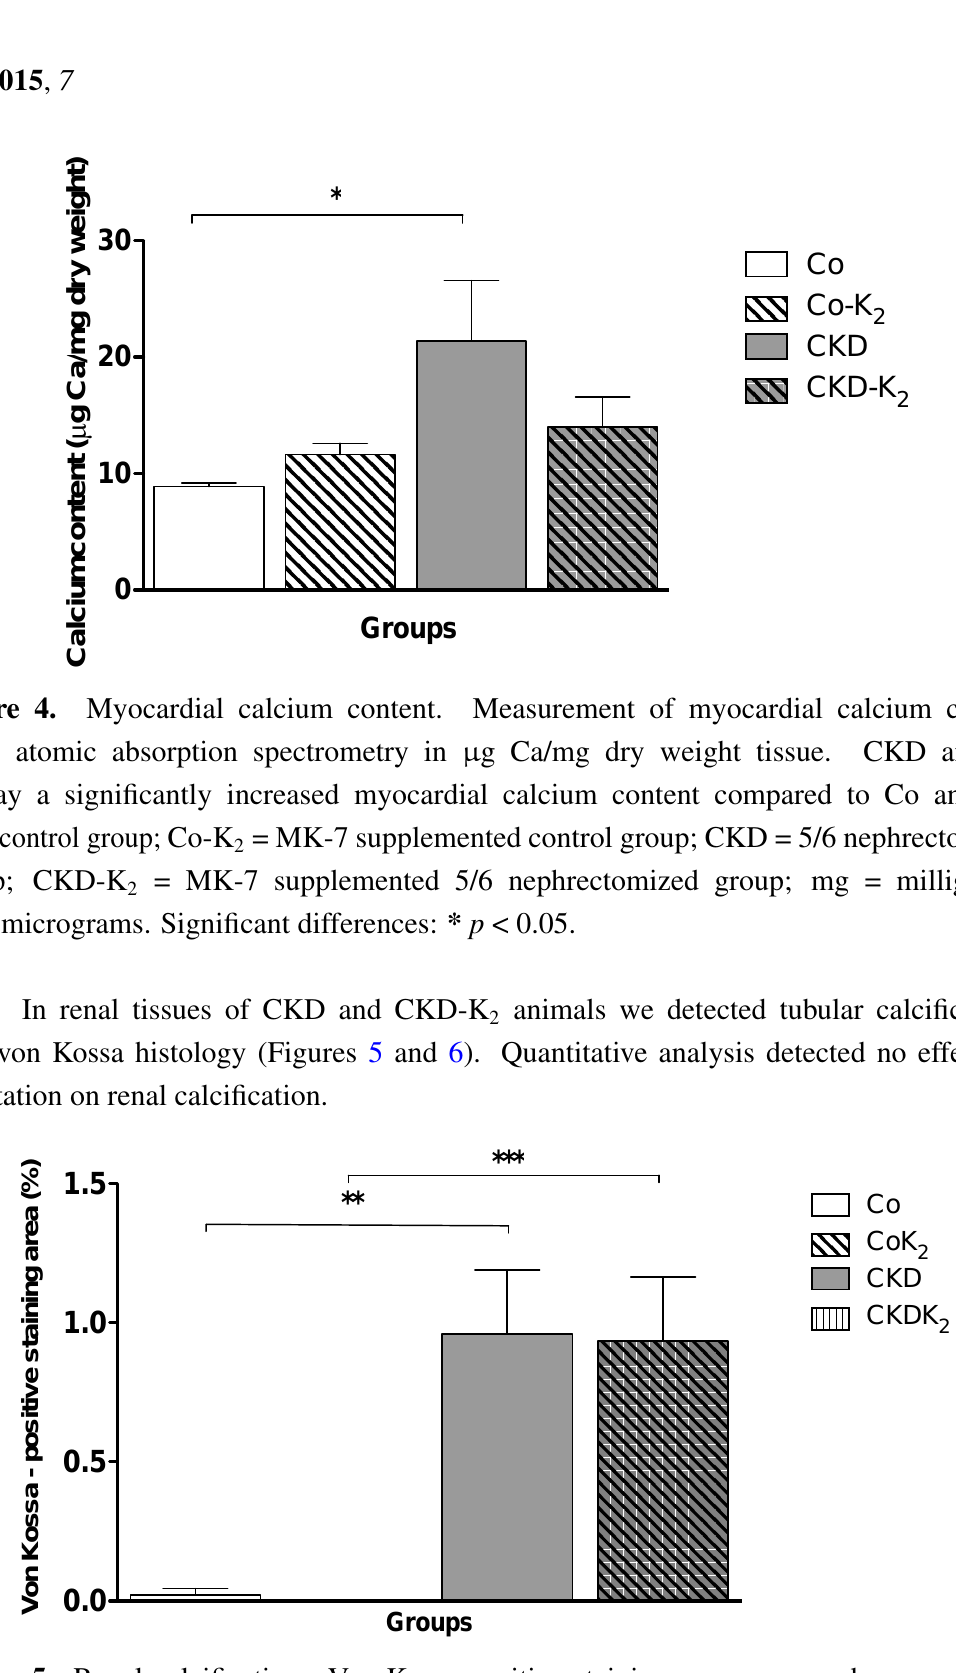
Figure 5. Renal calcification. Von Kossa positive staining area expressed as percentage of tissue area. In 5/6 nephrectomized animals significantly more von Kossa positivity was measured as compared to the control groups. No differences were seen between CKD and CKD-K 2 treated groups. Co = control group; Co-K 2 = MK-7 supplemented control group; CKD = 5/6 nephrectomized group; CKD-K 2 = MK-7 supplemented 5/6 nephrectomized group. Significant differences: ** p < 0.01, *** p < 0.001.